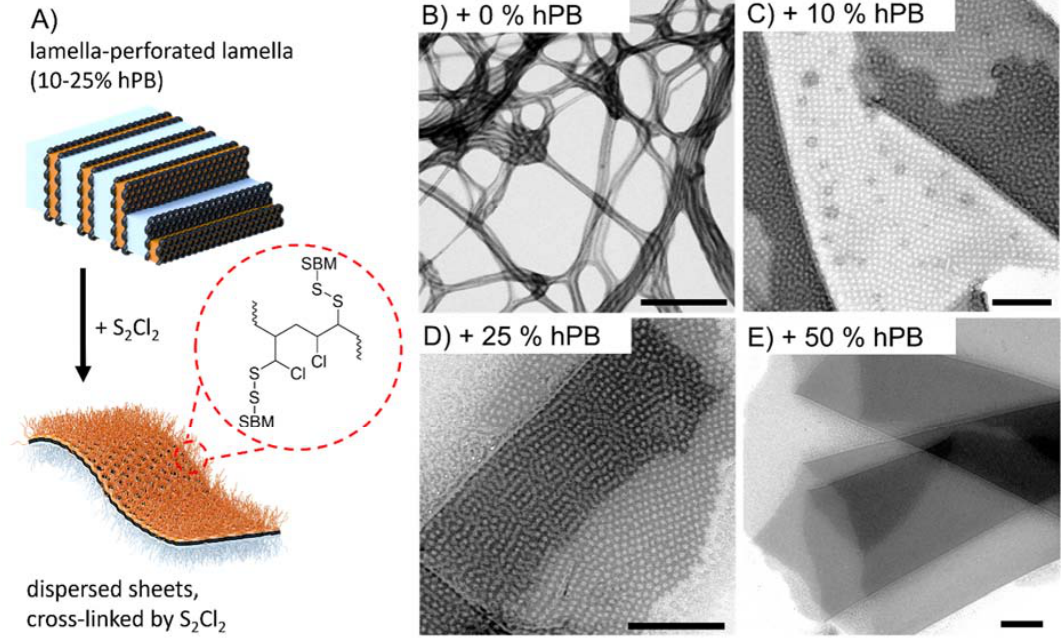
Figure 6. Crosslinking and redispersion of SBM / B morphologies into Janus nanostructures. ( A ) Schematic of lamella-perforated lamella morphology and perforated Janus sheets after crosslinking. ( B–E ) TEM images of crosslinked Janus nanostructures, redispersed in